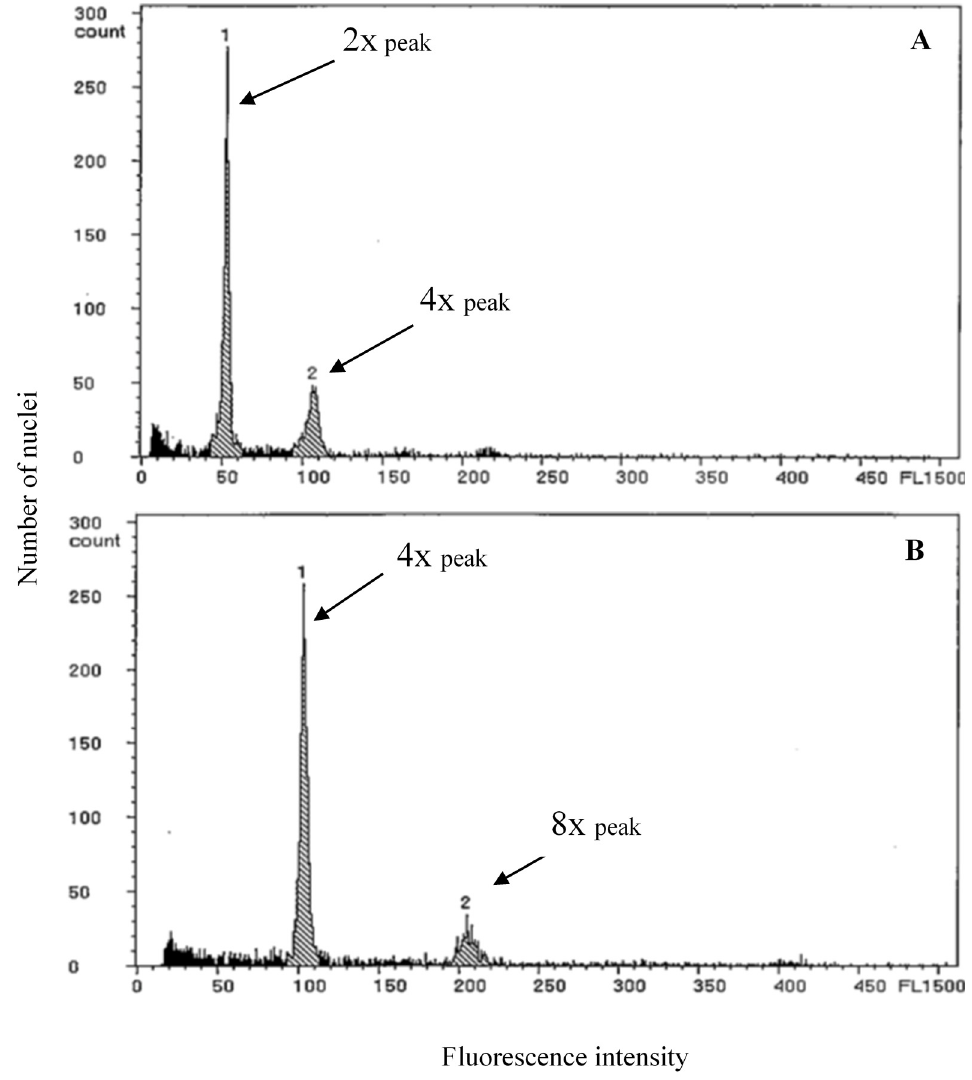
Figure 3. Histograms of the relative nuclear DNA content obtained from the flow cytometric analysis of the pointed gourd. ( A ) Diploid mother plant; ( B ) tetraploid of the PGF19 × PGM09 seedling.